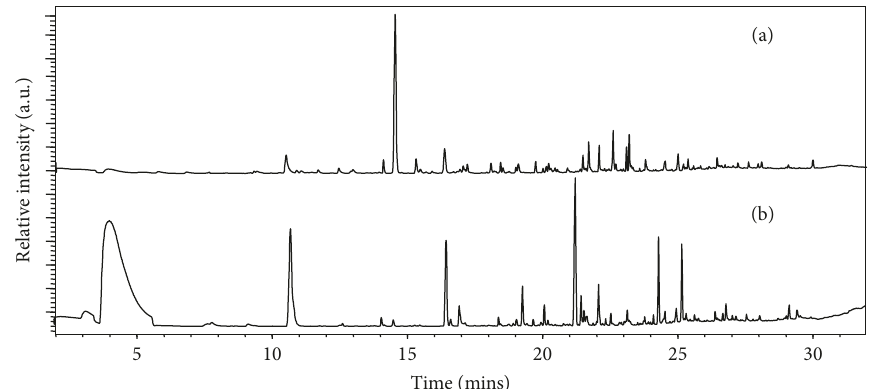
Figure 1: Total ionic chromatogram profiles of the unfermented juice (a) and fermented juice